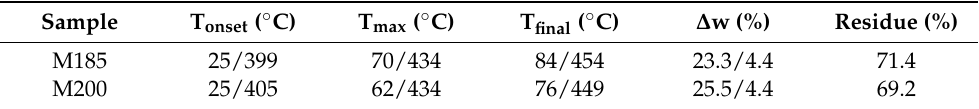
Table 4. TGA (Thermal Gravimetric Analysis) characteristics temperatures and main parameters of the thermal events displayed by both mortars studied (heating rate of 10 ◦ C/min). Sample T onset ( ◦